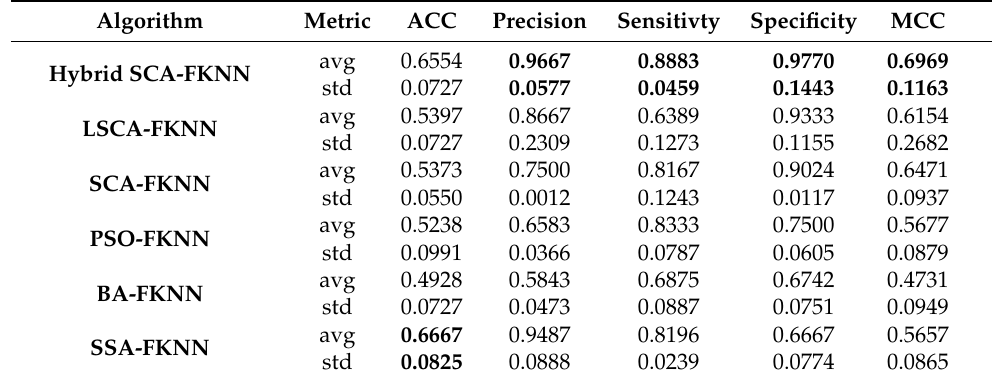
Table 12. Results of the hybrid-FKNN and comparison models on the breast tissues dataset. (Bold indicates the best in comparison method).